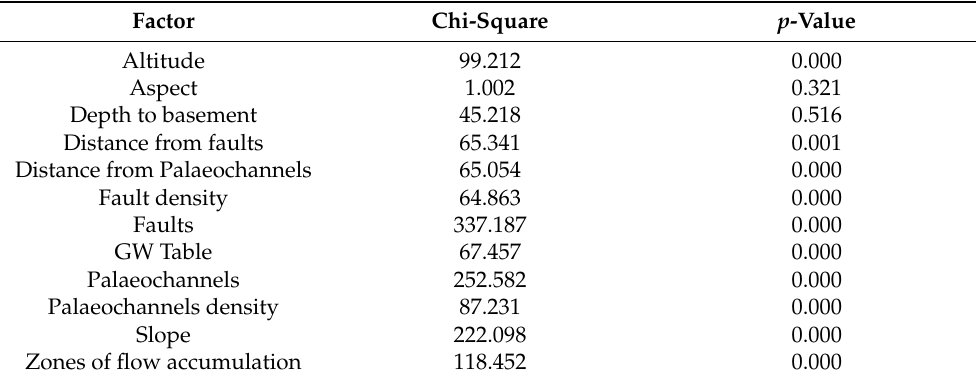
Table 1. Importance of each GWCF calculated using chi-square method. Factor Chi-Square p